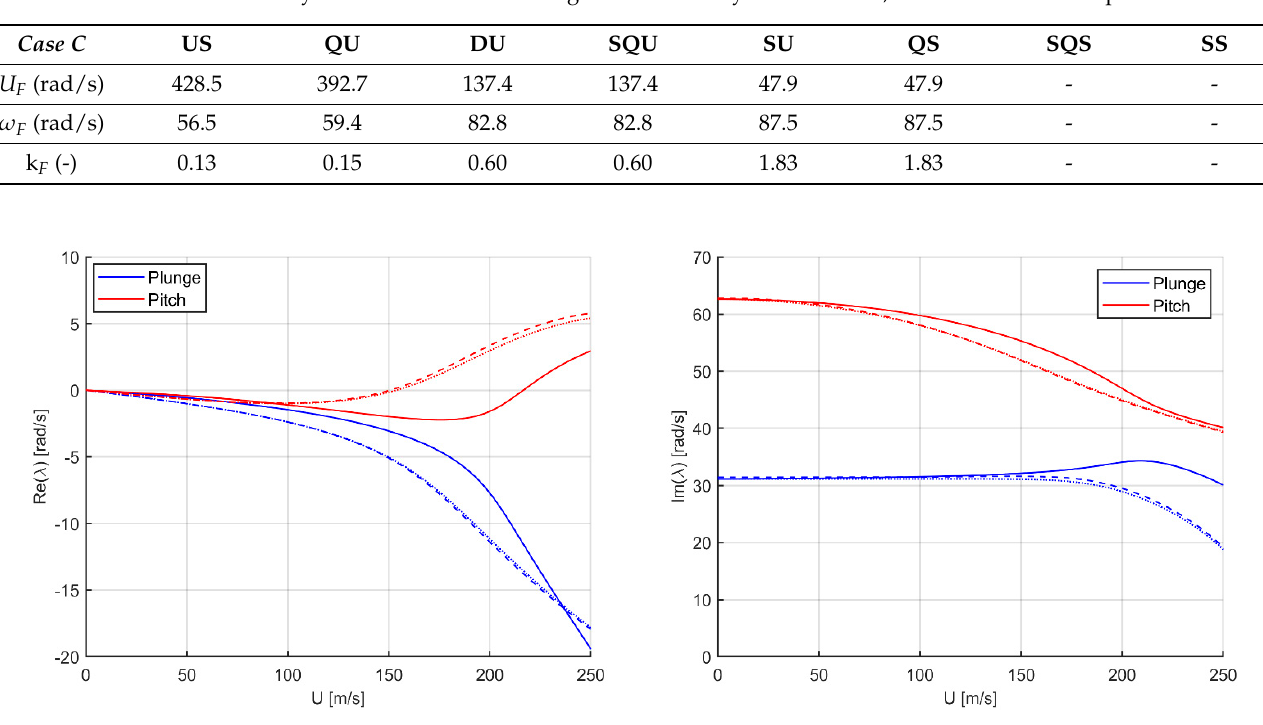
Figure 7. Evolution of the complex eigenvalues for Case C: real part ( left ), imaginary part ( right ); continuous, dashed and